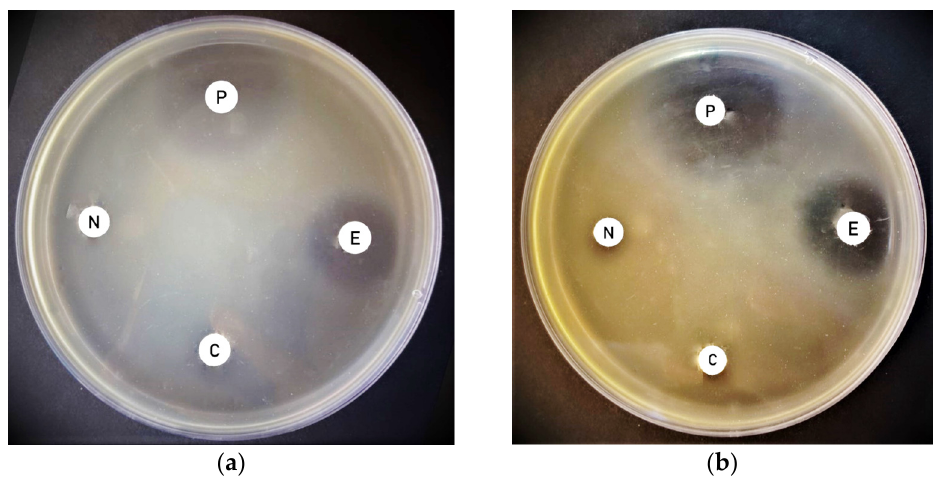
Figure 3. An agar plate showing the greatest inhibition zone of extract derived from biomass pre-exposed to laser and extract directly exposed to laser of Synechococcus elongatus against Pantoea vagans at 10 cm. ( a ) Effect of laser treatment for different exposure times with 4 min intervals at a distance of 10 cm. ( b ) Effect of laser treatment for different exposure times with 16 min intervals at a distance of 10 cm. (P) positive control—(N) negative control—(C) an extract derived from cyanobacterial biomass pre-exposed to laser—(E) an extract directly exposed to laser.